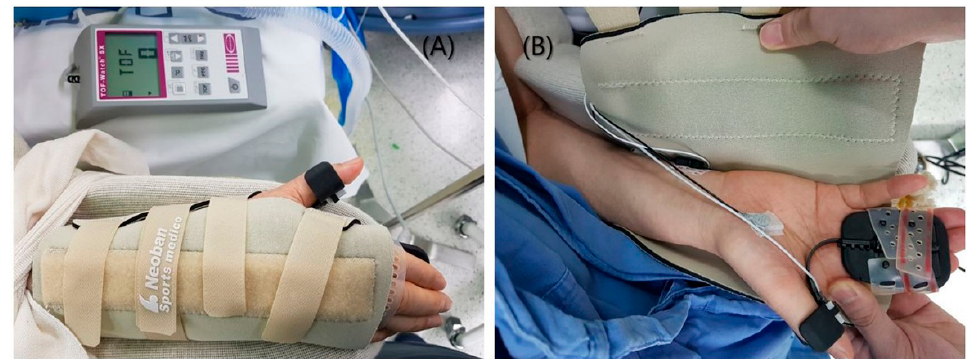
Table S1: CONSORT 2010 checklist of information to include when reporting a randomized